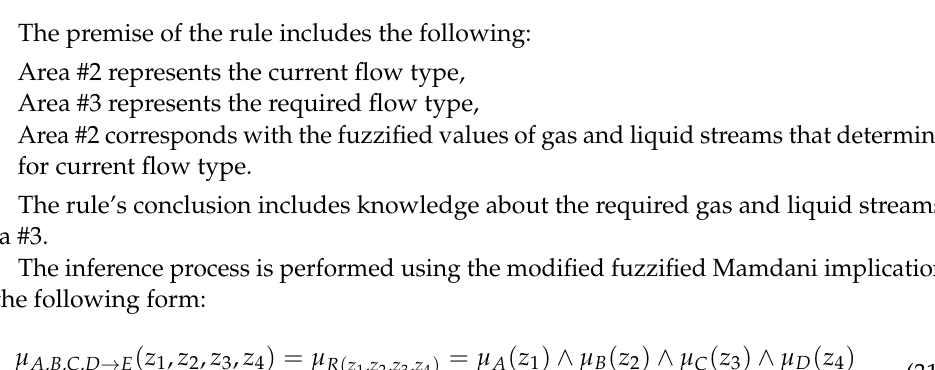
Figure 5. The graphical interpretation of the inference rule defined with the Equation